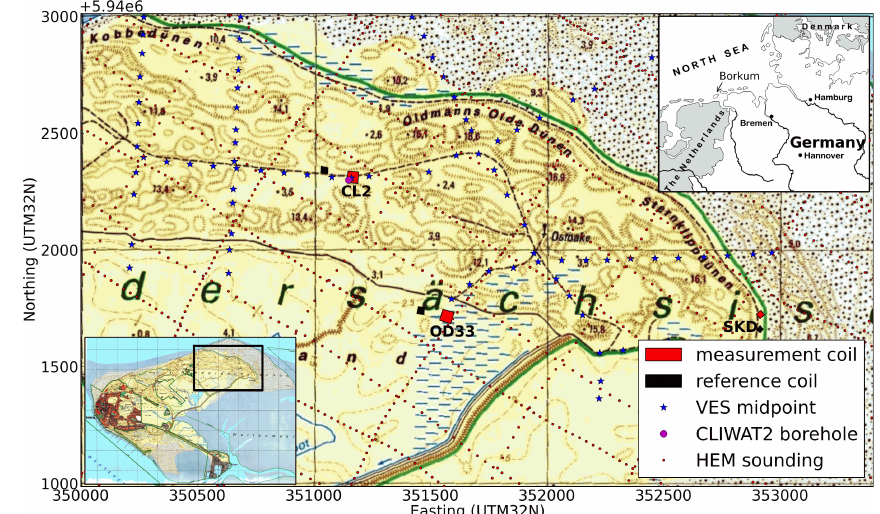
Fig. 1. Measuring area in the east of Borkum and locations of MRS measurement (red) and reference (black) coils, VES midpoints (blue tri-stars), the CLIWAT II borehole (magenta) and HEM soundings (red dots) in the east dunes of